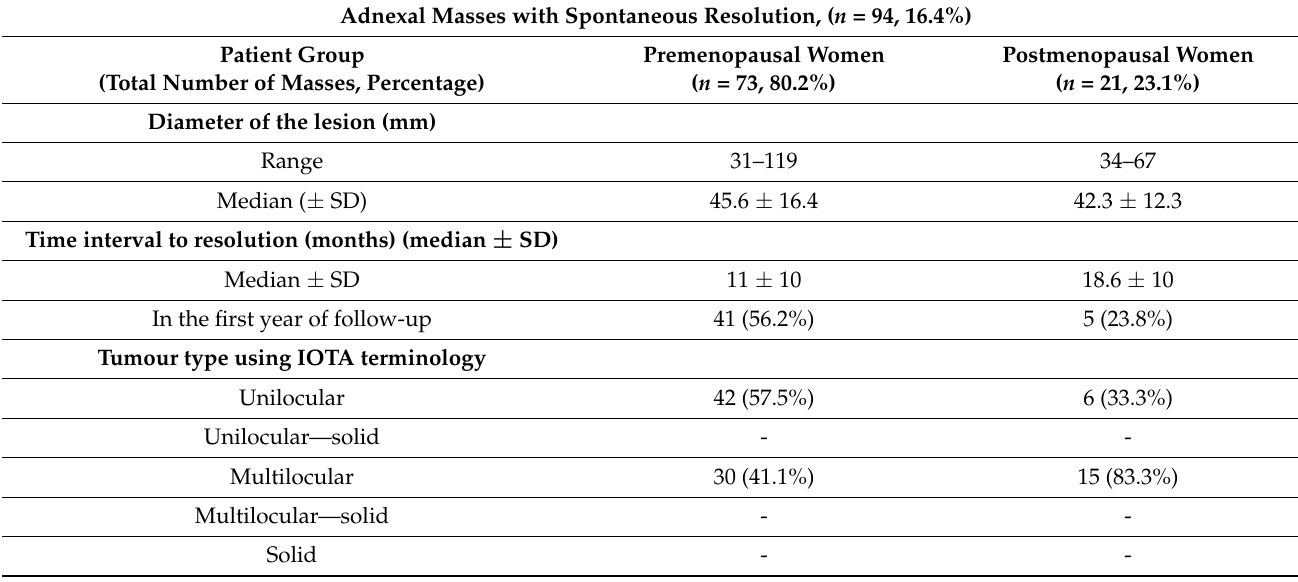
Table 4. Spontaneous resolution of adnexal masses observed during